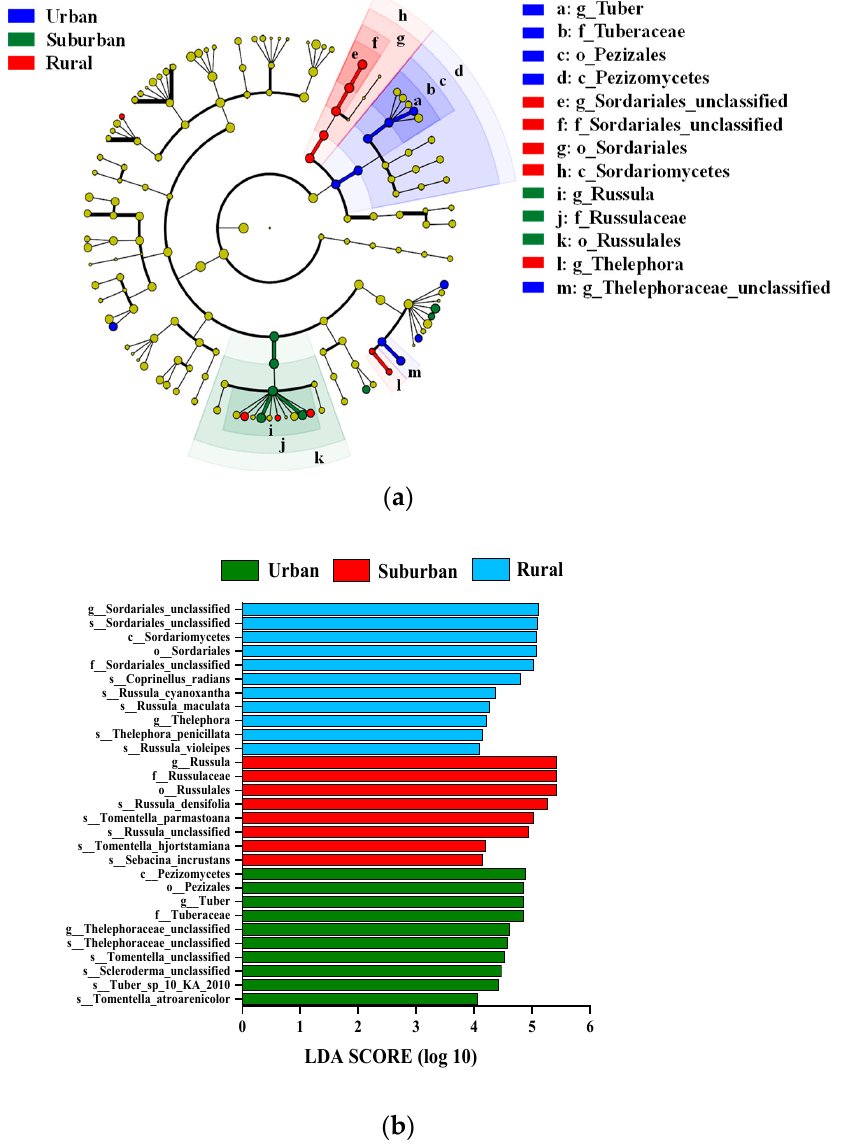
Figure 4. Cladogram ( a ) and LDA distribution histogram ( b ) for ECM fungi in the soil of Quercus acutissima forests along the urban–rural gradient.